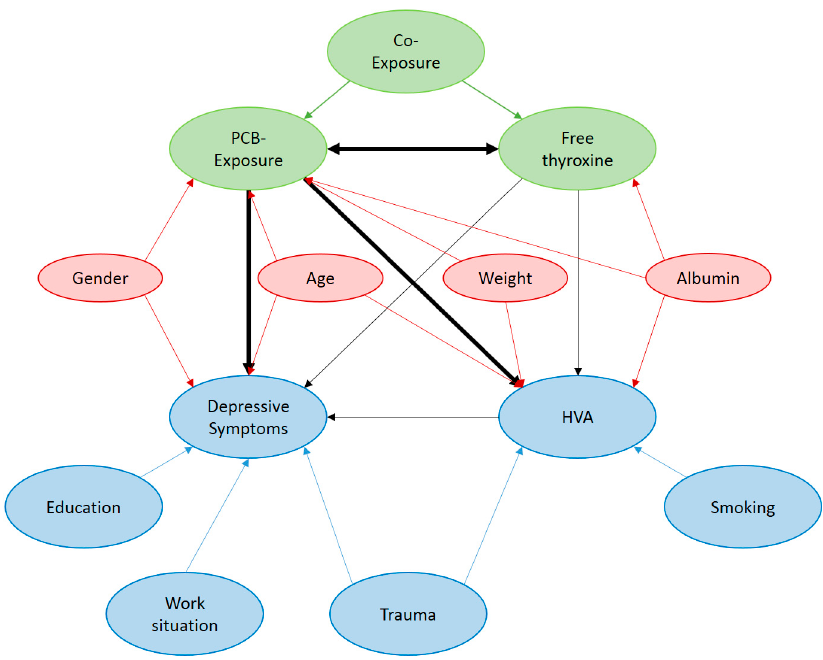
Figure A1. Directed acyclic graph for identifying relevant control variables (red colored variables).